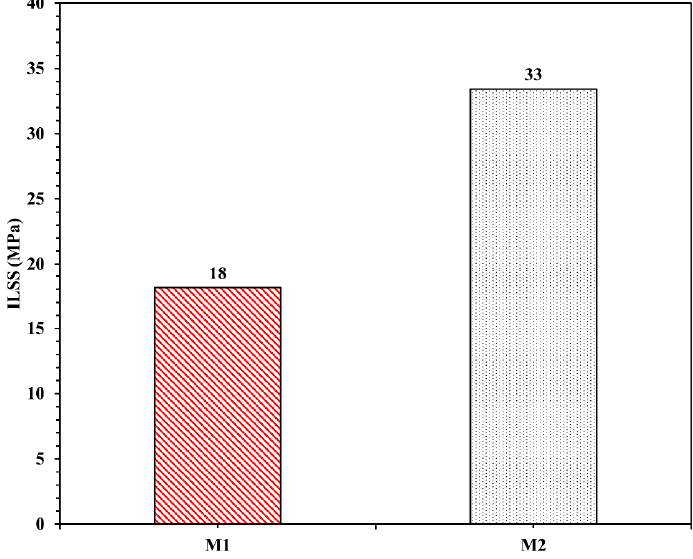
Figure 15. Normalized average ILSS of each set showing the improvement of 83% caused by optimal fiber dispersion in Method 2 when compared to Method